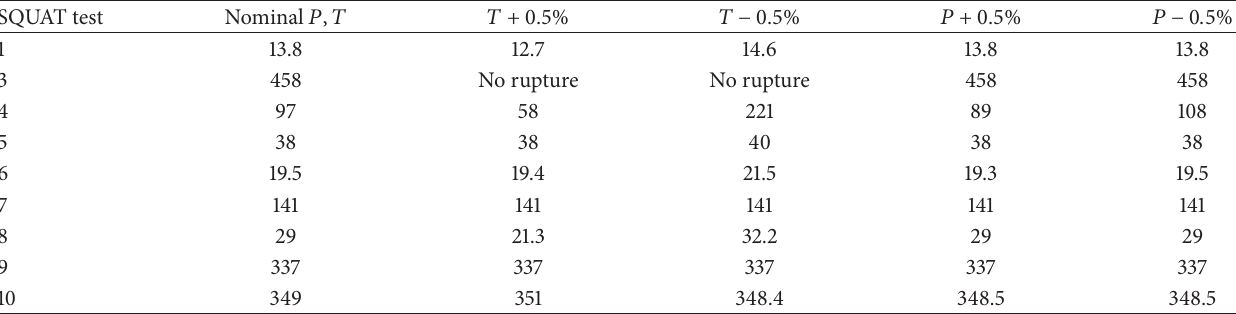
Table 5: Sensibility calculations on the SQUAT tests pressure and the